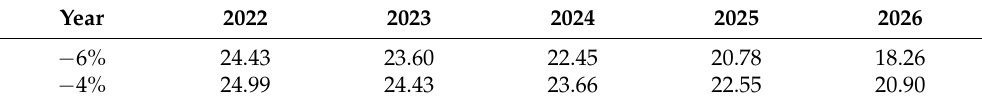
Table 13. Prediction result of water requirement with different growth rates of AVSI in Tianjin.